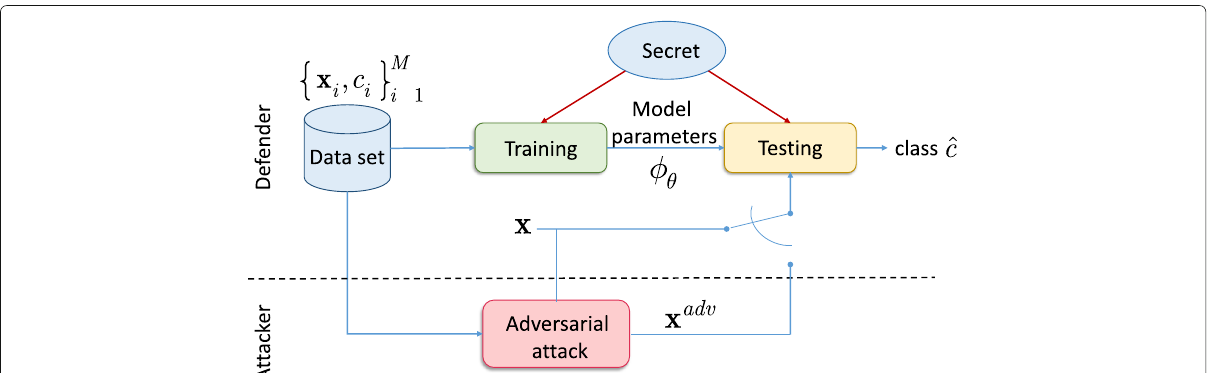
Fig. 1 The information access diagram: the defender has an access to the training data and secret shared between the training and test stages while the attacker has only access to the shared training data